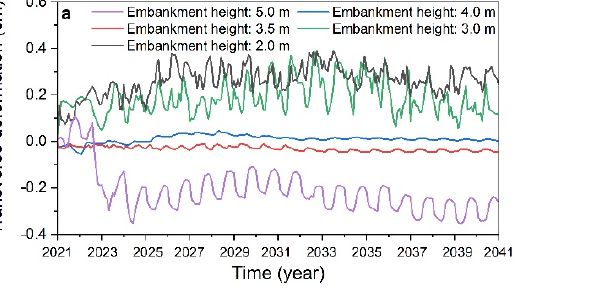
Figure 12. Transverse deformation curves at the road centerlines and shoulders of different structures: ( a ) at the road centerline and ( b ) at the shoulder.